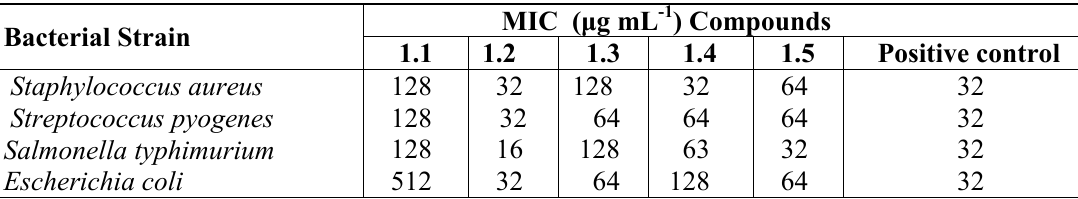
Table 2. Minimum inhibition concentration (MIC) of the chalcone and its cyclized products, positive control: